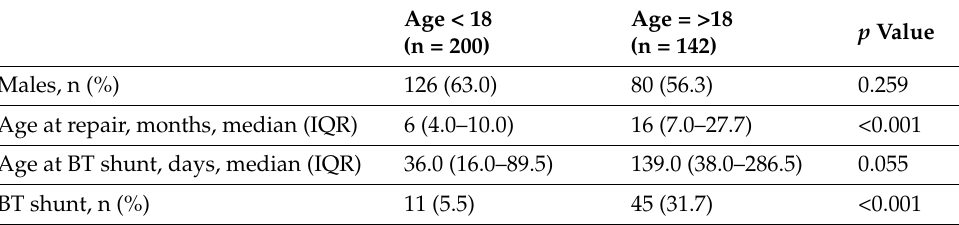
Table 3. Clinical and MRI characteristics according to age. Legend: BT shunt = Blalock–Taussig shunt; TP = transannular patch; BSA = body surface area; BMI = body mass index; RVEDVi = right ventricular end-diastolic volume indexed by BSA; RVESVi = right ventricular end-systolic volume indexed by BSA; RVEF = right ventricular ejection fraction; LVEDVi = left ventricular end- diastolic volume indexed by BSA; LVESVi = left ventricular end-systolic volume indexed by BSA; LVEF = left ventricular ejection fraction; PR = pulmonary regurgitation fraction; RVOT = right ventricular outflow tract; PAs = pulmonary arteries; PVR = pulmonary valve replacement; NS-VT = non-sustained ventricular arrhythmias; S-VT = sustained ventricular arrhythmias; AA = atrial arrhythmia; PMK =